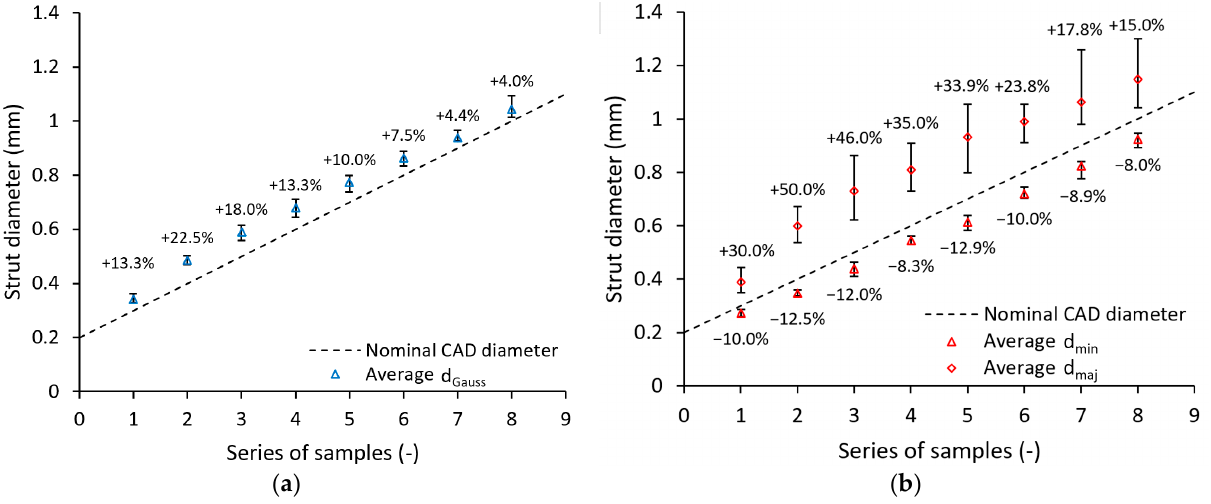
Figure 9. Difference between nominal and measured dimensions for ( a ) Gauss circular and ( b ) elliptical measurement; numbers above/beneath points show the percentage of dimension increase/decrease compared to CAD data.